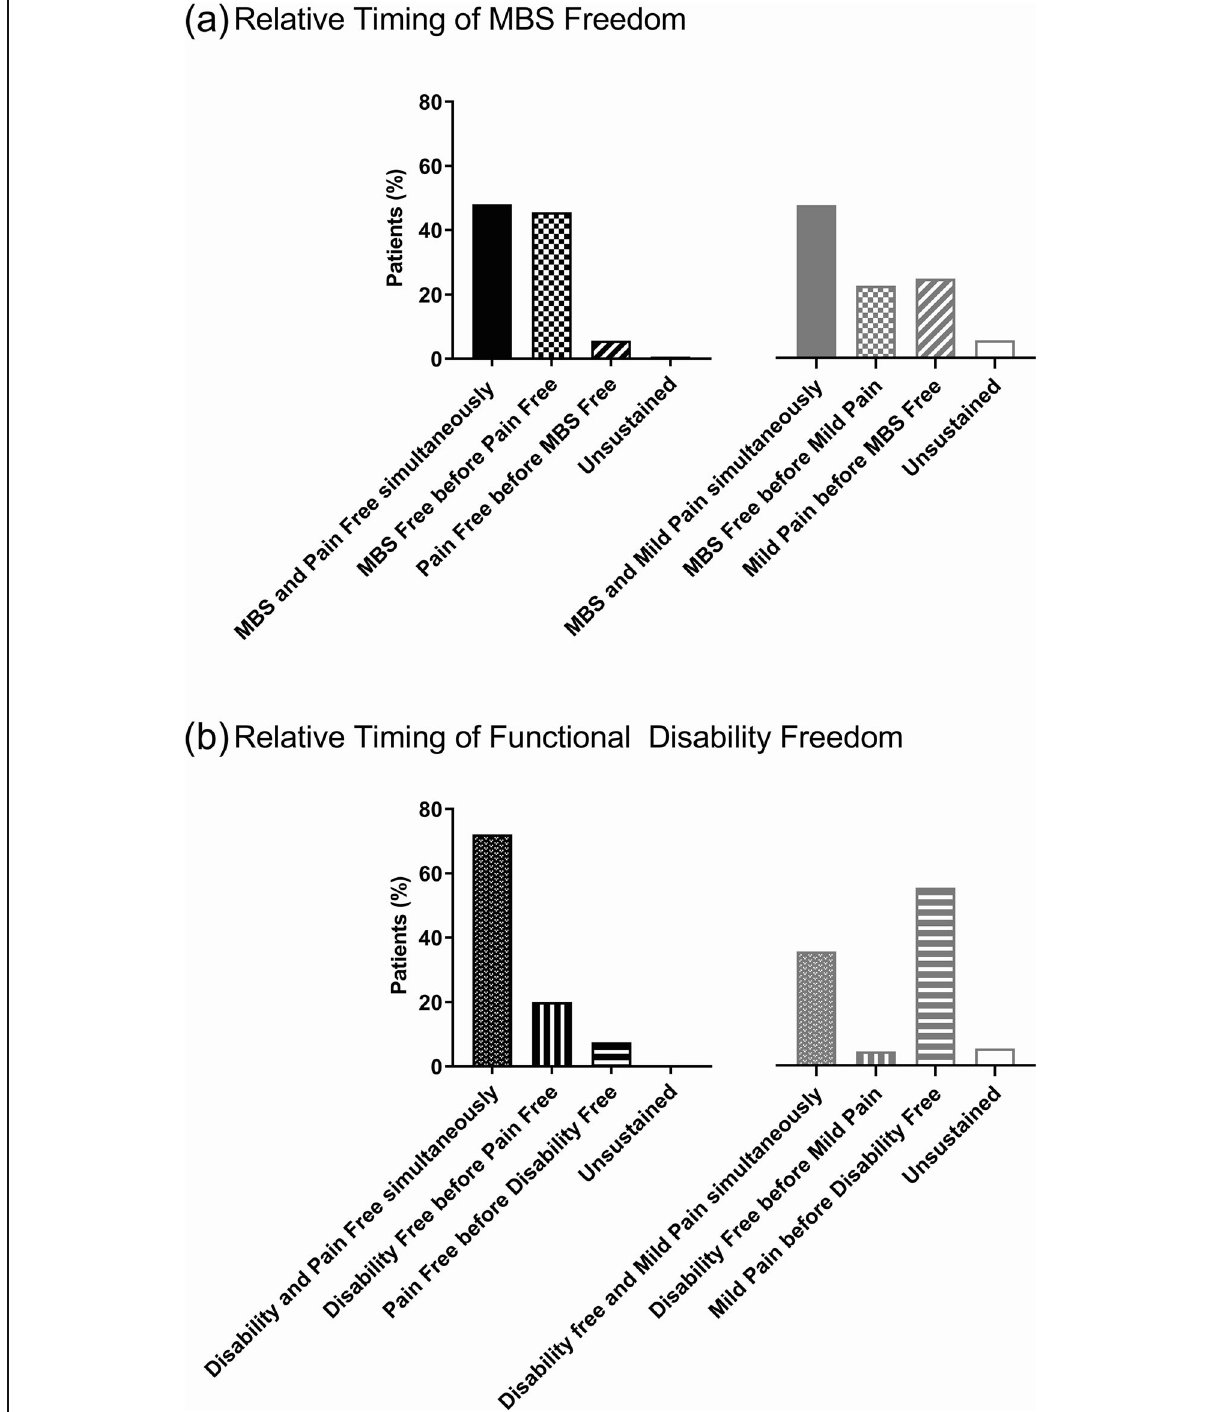
Fig. 1 Relative timing of freedom from most bothersome symptom (MBS) or functional disability and pain status. ( a ) Sequence of outcomes in patients that experienced MBS freedom and either pain freedom ( N = 839) or mild pain ( N = 388) at 2 h. ( b ) Sequence of outcomes in patients that experienced functional disability freedom and either pain freedom ( N = 795) or mild pain ( N = 116) at 2 h. Notes: Unsustained represented patients who experienced freedom from MBS or functional disability freedom and either freedom from pain or improvement to mild and then moved out of that group prior to 2 h post-dose. The denominator was the total population that achieved the MBS freedom or disability freedom at 2 h post-dose in either the pain free or mild pain